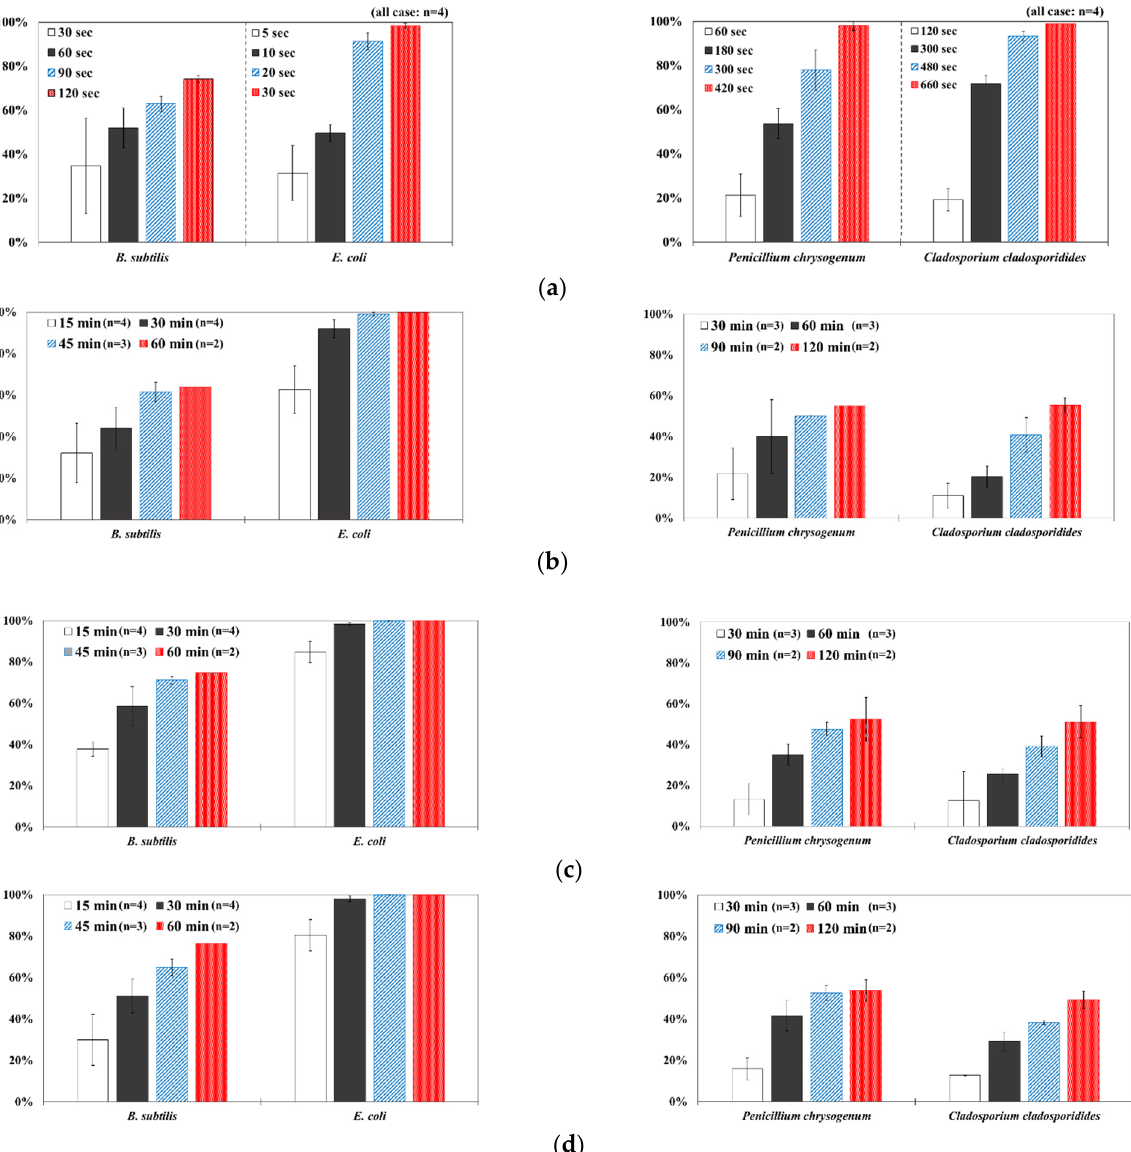
Figure 3. Inactivation rates (±std) of the four microorganisms by LED wavelength. (n indicates the number of replicates experiments.) ( a ) Reduction rate with microorganisms at 275 nm. ( b ) Reduction rate with microorganisms at 370 nm. ( c ) Reduction rate with microorganisms 385 nm. ( d ) Reduction rate with microorganisms 405 nm.